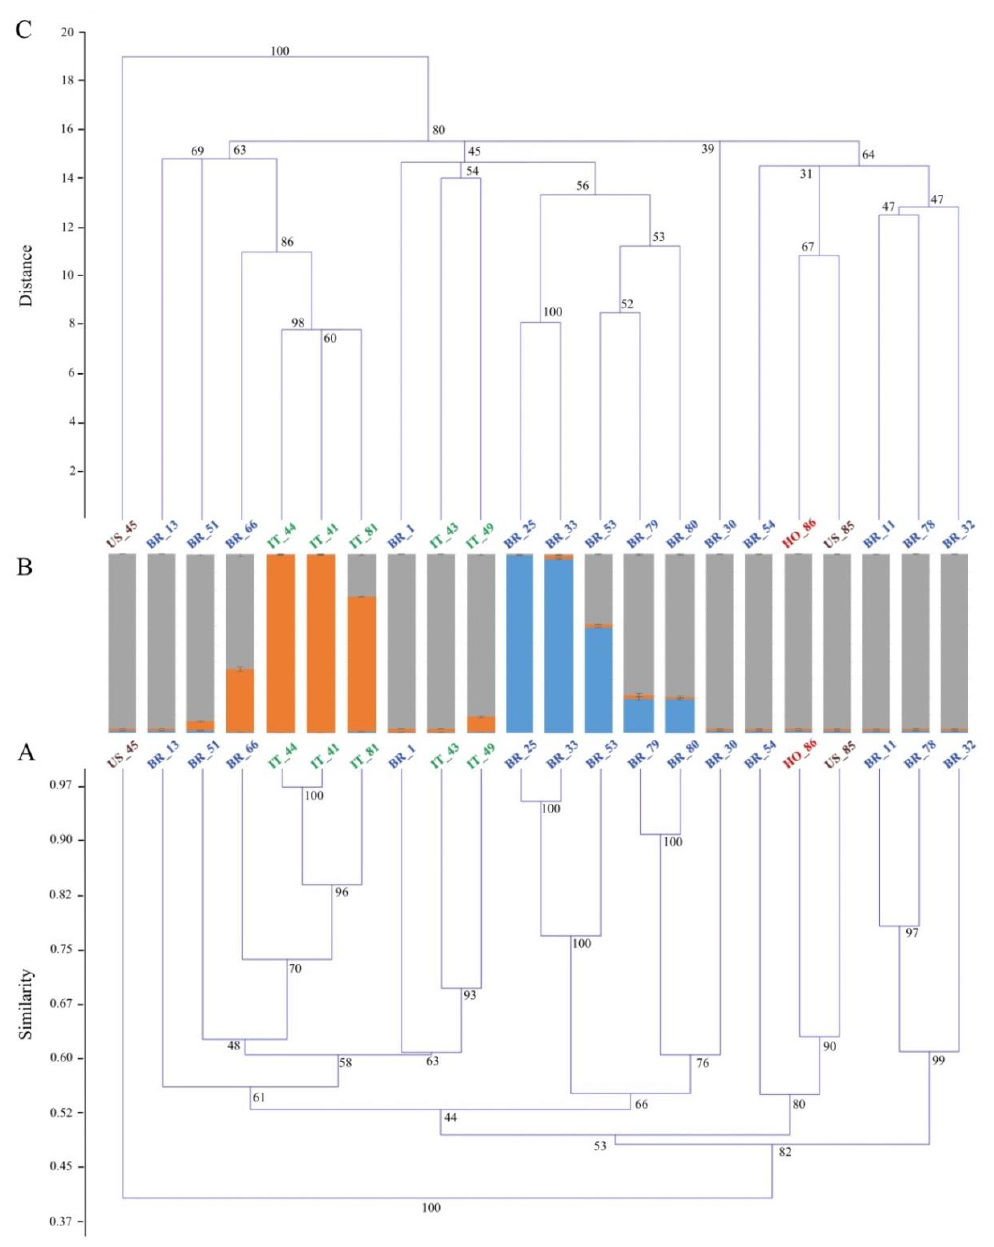
Figure 2. Genetic structure analysis of the sweet potato core collection: ( A ) The unweighted pair group method with arithmetic average means (UPGMA) tree of the genetic similarity estimates computed among pairwise comparisons of sweet potato accessions using the whole simple sequence repeat (SSR) marker data set, with nodes of the main subgroups supported by bootstrap values. The color scheme for this figure is the same as that used in Figure 1 (Blue = Brazil, red = Honduras, green = Italy, and brown = USA). ( B ) Population genetic structure of a core collection of N = 22 sweet potato accessions estimated using 11 microsatellite markers. Each sample is represented by a vertical bar partitioned into K = 3 colored segments representing the estimated membership. The proportion of ancestry (%) is reported on the ordinate axis, and the identification number of each accession is indicated below each histogram. ( C ) The unweighted pair group method with arithmetic average means (UPGMA)-constrained tree was built by applying the Euclidean similarity index and using the morpho-qualitative measurements of a subset of the I. batatas core collection. The positions of the samples throughout the dendrogram were kept fixed according to those ones resulting from the dendrogram in Figure 2A, and the bootstrap values supporting each node of the main subgroups were calculated.